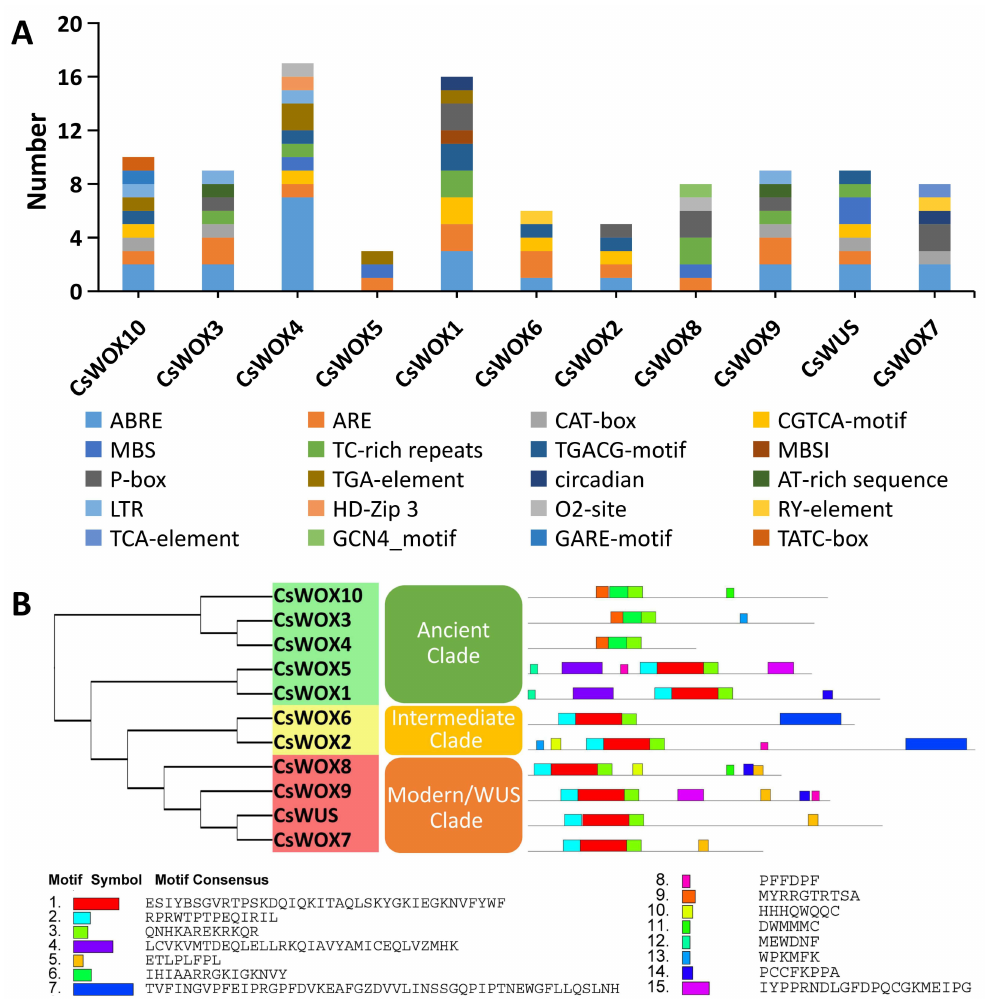
Figure 2. Cis-regulatory elements in promoter region of CsWOX genes and motif analysis of CsWOXs. ( A ) Cis-regulatory elements were identified in 1500 bp promoter sequence upstream of start codon of CsWOX genes using the online tool PlantCARE and PLACE. These elements are related to different functional diversity, represented by different colors. ( B ) Motif analysis of CsWOX proteins. Colors of boxes indicate different motif numbers; length of box shows motif